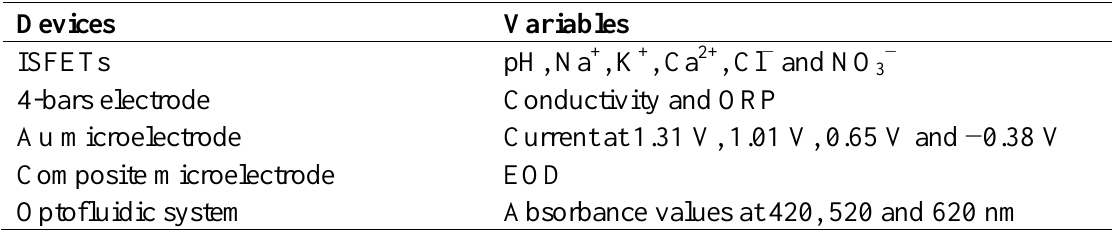
Table 2. Variables considered for constructing the